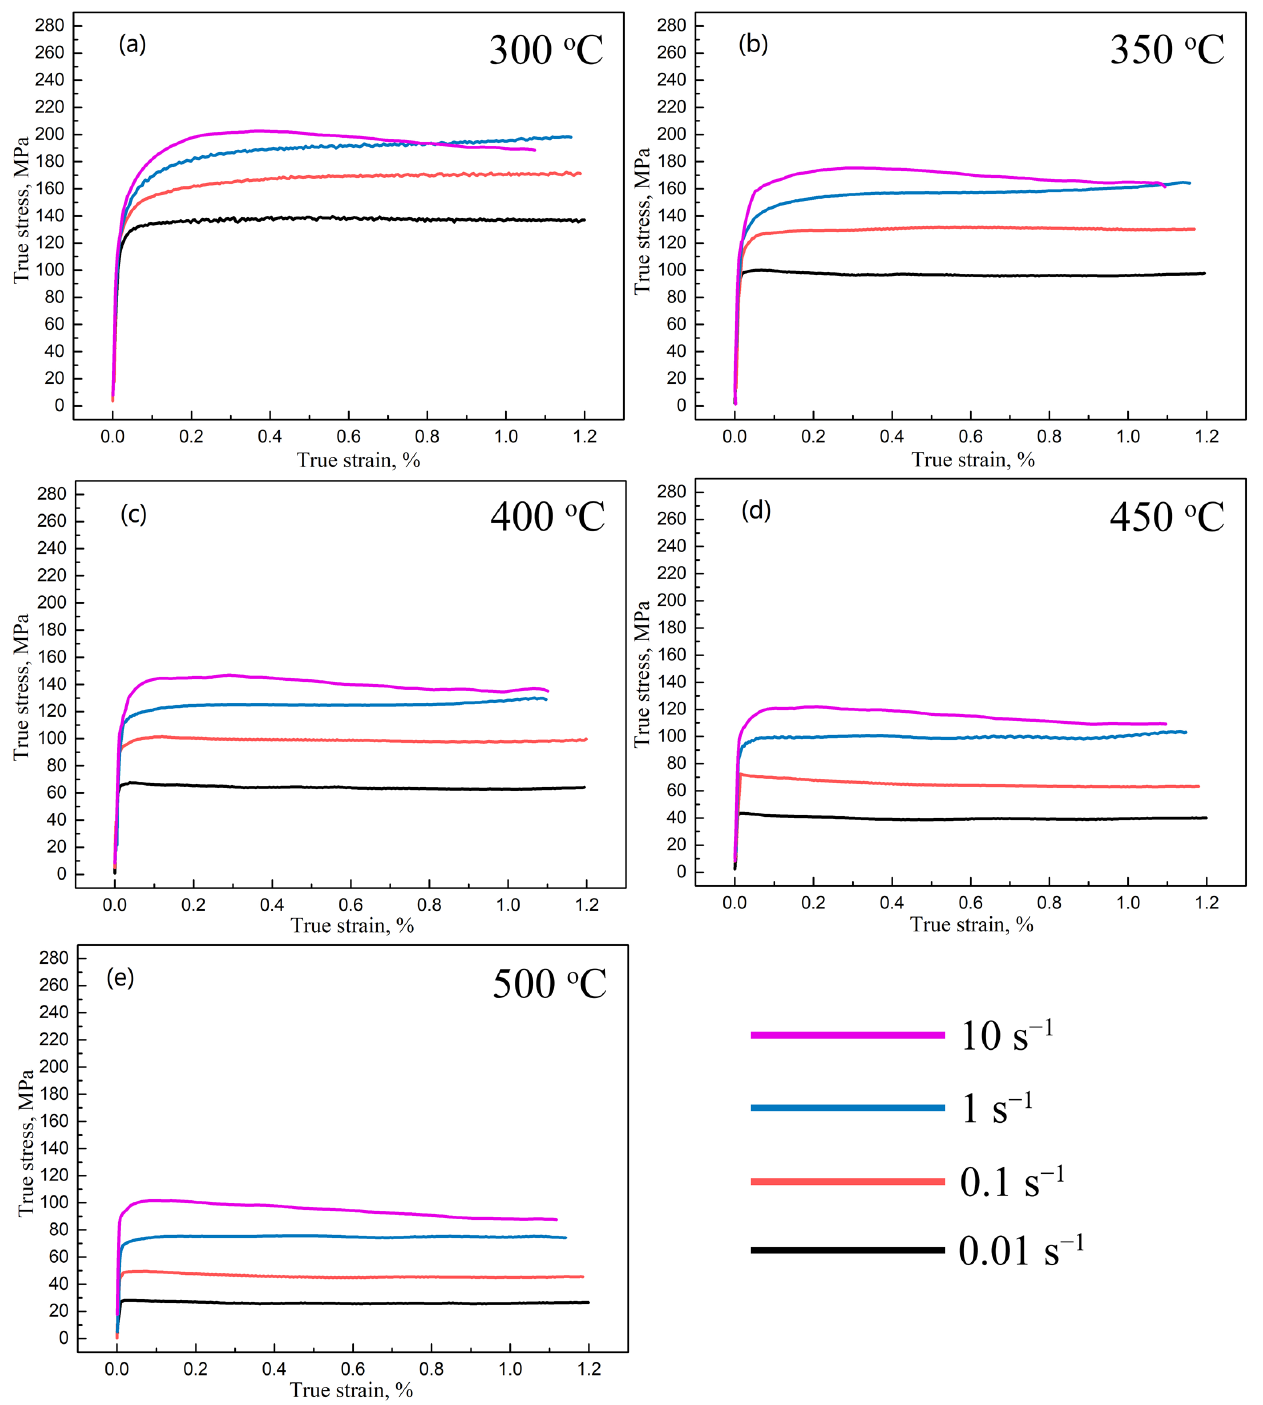
Figure 2. Hot compression true stress − strain curves of A alloy (5182 alloy) at ( a ) 300 °C, ( b ) 350 °C, ( c ) 400 °C, ( d ) 450 °C, and ( e ) 500 °C.